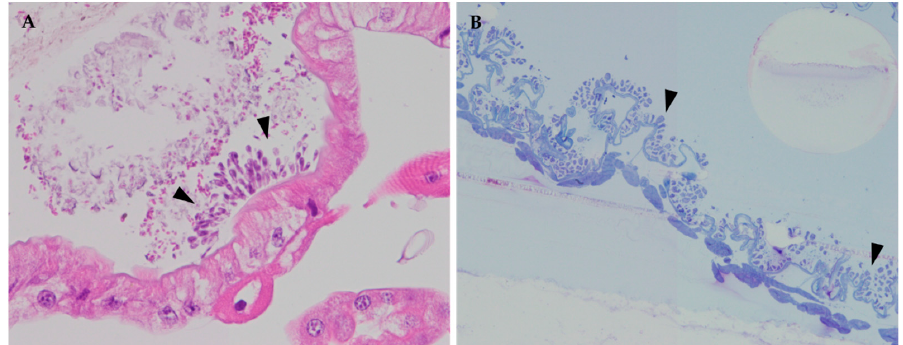
Figure 1. Light microscopy images of the ileum ( A ) and rectum ( B ) of workers infected with C. acanthocephali : ( A ) longitudinal section (40 × ) of the ileum stained with hematoxylin and eosin (H&E), in which trypanosomatid clusters could be observed (arrowheads); ( B ) methylene blue- stained longitudinal semi-thin section (20 × ) of the rectum, covered by a layer of trypanosomatid cells